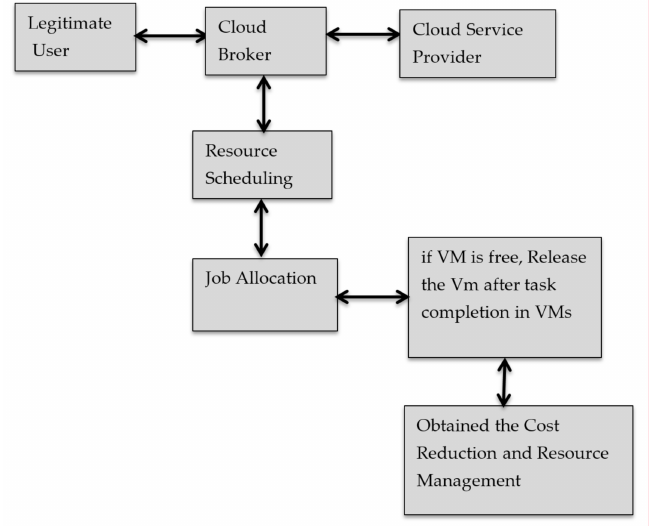
Figure 2. Workflow of Resource Scheduling Santhiya et al.